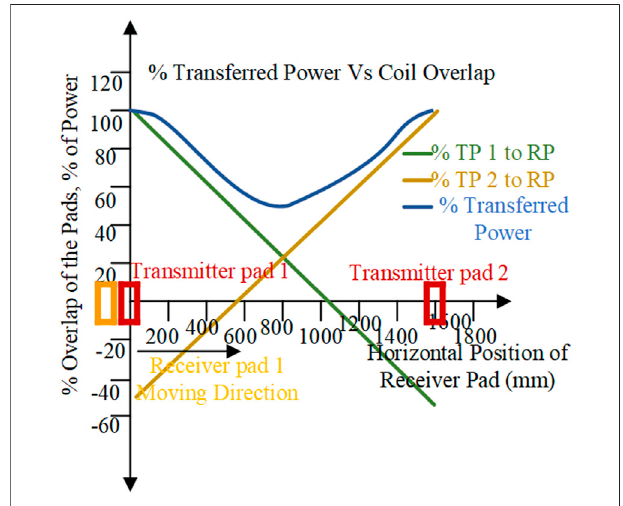
FIGURE 3 | Characteristics of power transfer (Miller et al.,